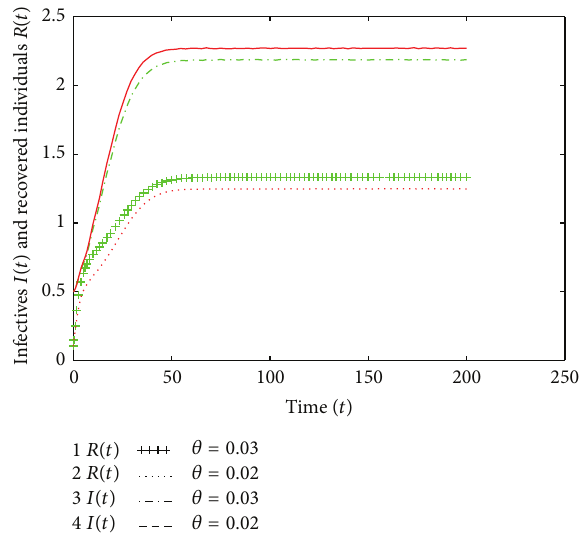
Figure 4: Variation of infective population 𝐼(𝑡) and recovered population 𝑅(𝑡) with time for different values of 𝜃